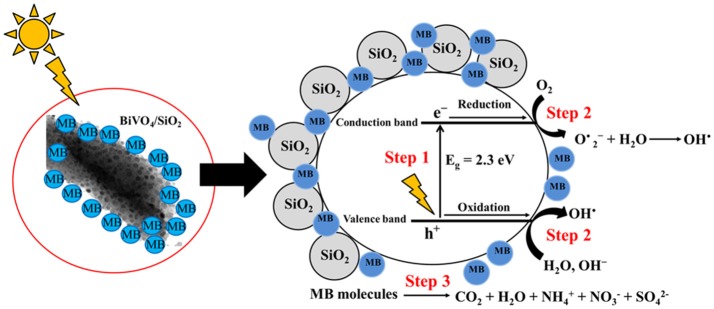
The proposed mechanism of photogenerated charge carriers of BiVO4 in BiVO4/SiO2 heterojunction.